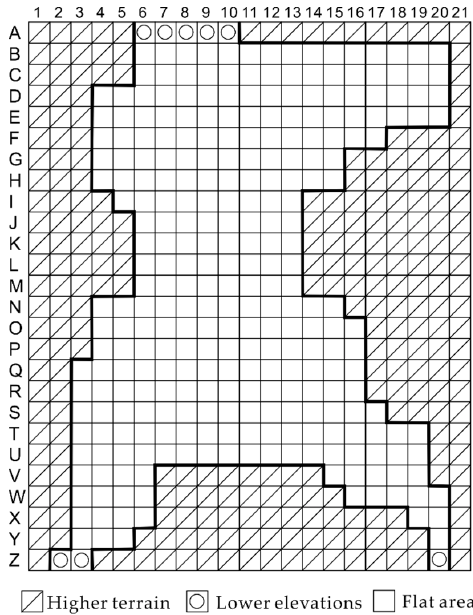
Figure 5. Saddle-shaped surface surrounded by higher terrain.